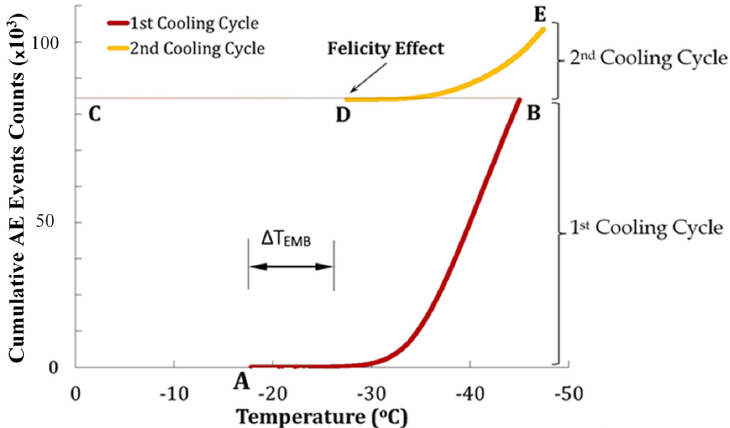
Figure 14. Typical AE test results of thermal cyclic loading of laboratory samples. Please note the presence of the Felicity effect as a result of self ‐ healing.